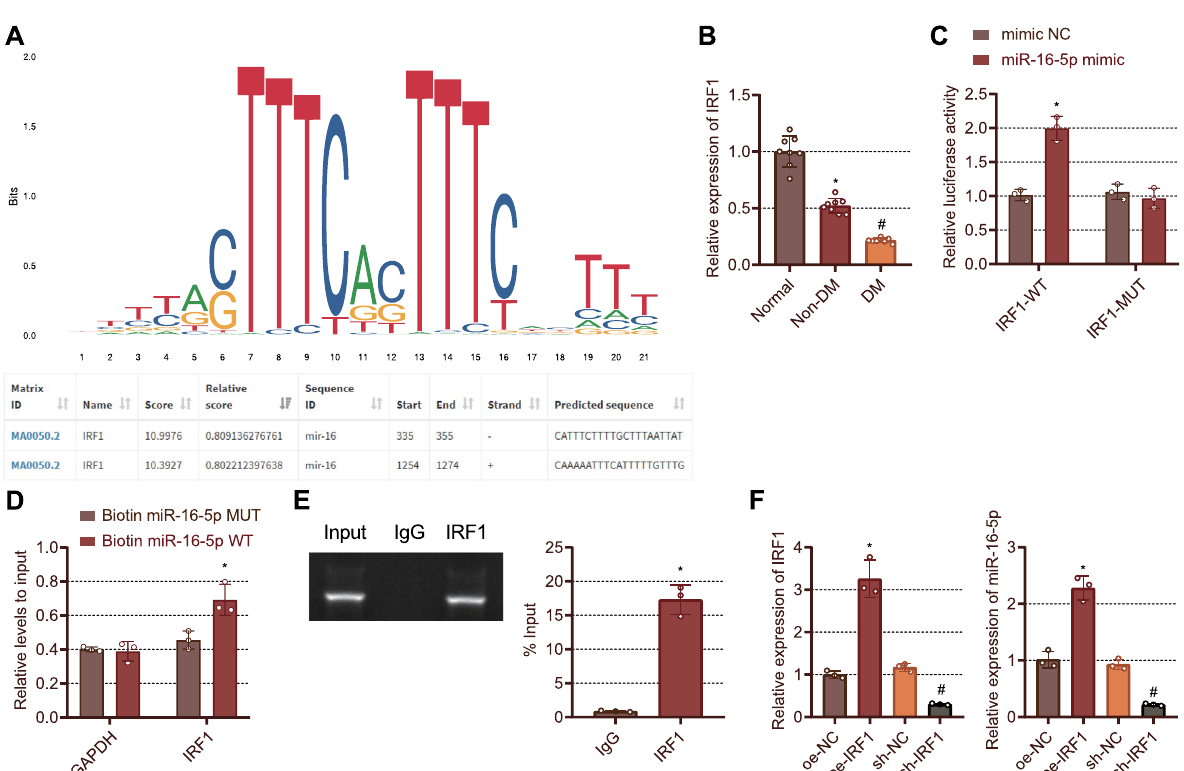
Fig. 3 IRF1 targets miR-16-5p and increases its expression in fibroblasts. A The motif and binding site of the upstream transcription factor IRF1 of miR-16-5p predicted by miRGen database. B IRF1 expression in normal foot tissues of normal rats and foot wound tissues of non-DM and DM rats detected by RT-qPCR. * p < 0.05 vs. normal rats; # p < 0.05 vs. non-DM rats. C Binding of IRF1 to the miR-16-5p promoter identified by dual-luciferase reporter assay. * p < 0.05 vs. the pMIR group. D Direct binding of IRF1 to miR-16-5p detected by RNA pull-down assay. E Binding of IRF1 to miR-16-5p validated by ChIP assay. * p < 0.05 vs. IgG group. F The expression of IRF1 and miR-16-5p in fibroblasts treated with oe-IRF1 or sh-IRF1 determined by RT-qPCR. * p < 0.05 vs. the fibroblasts treated with oe-NC. # p < 0.05 vs. the fibroblasts treated with sh-NC. Cell experiments were repeated three times. n 8. Measurement data were presented as mean standard deviation. Data among multiple groups were compared by one-way ANOVA, = ± followed by Tukey’s post hoc test for multiple